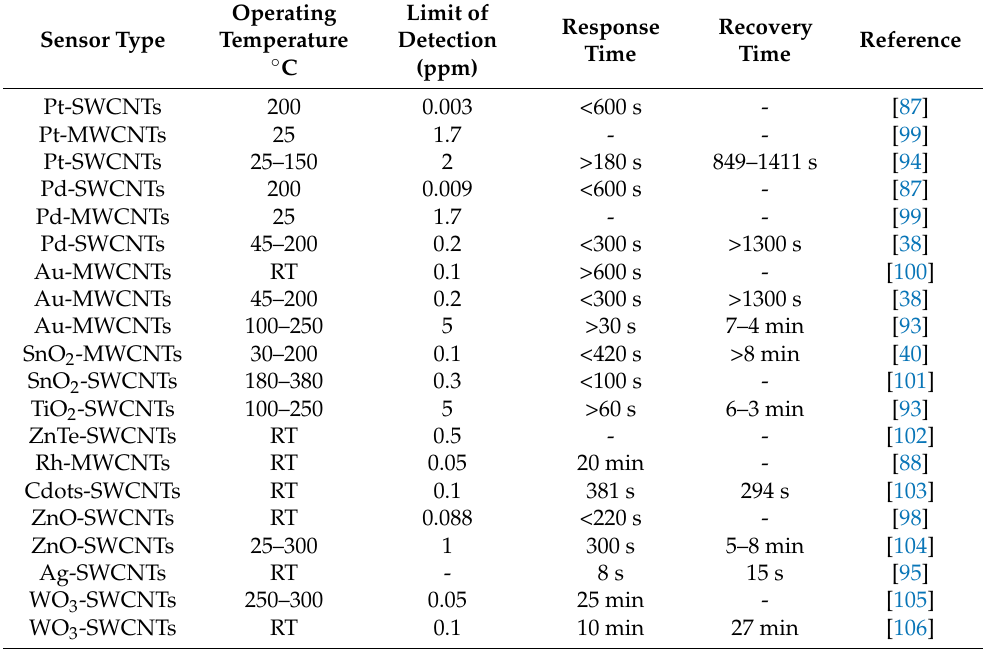
Table 1. Summary of NO 2 gas sensors based on CNTs decorated with